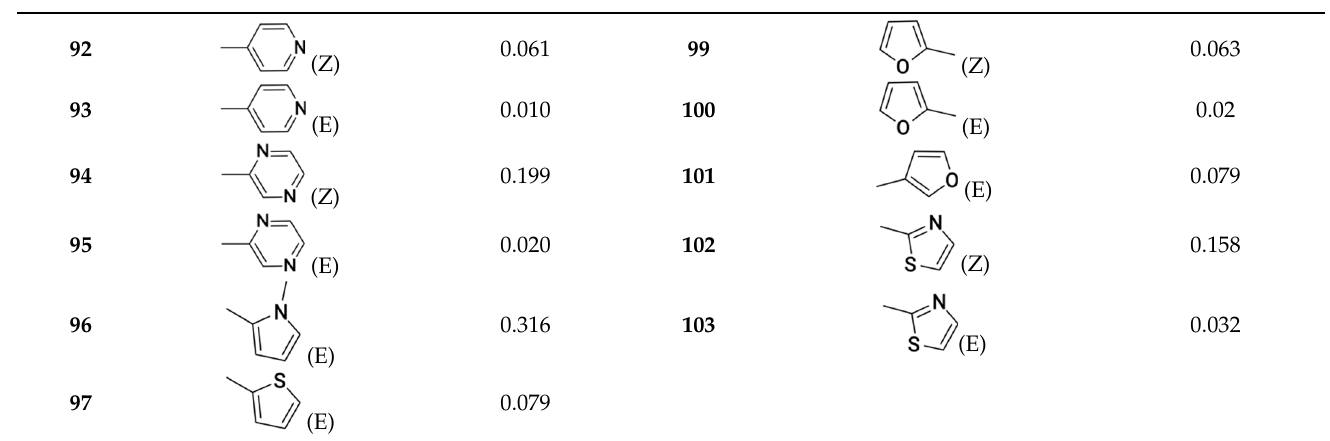
Table 2. Results of pharmacophore hypothesis for reverse transcriptase inhibitors.